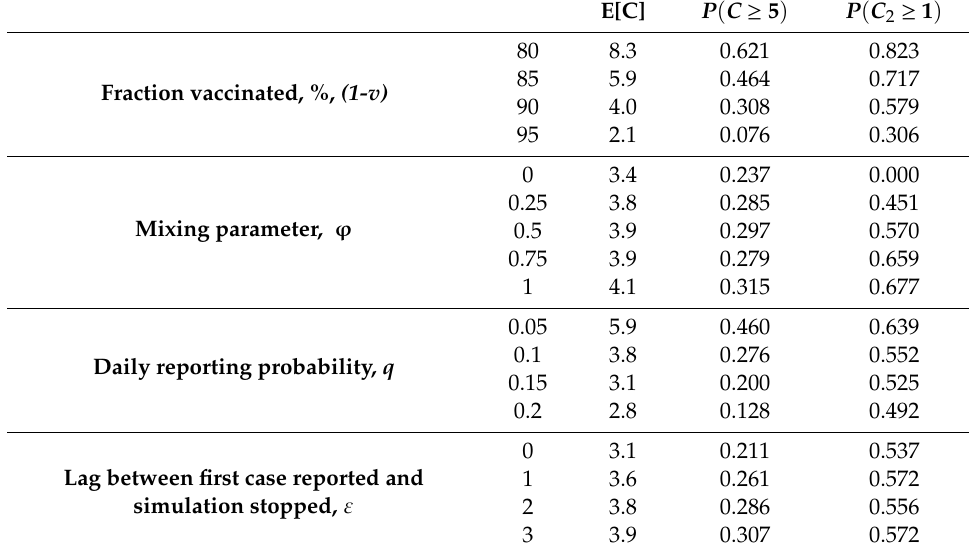
Table 4. Sensitivity analysis for two unequal-sized groups, an elementary school of 500 and a high school of 2000 individuals. The initial infection was in the elementary school and C 2 is the number of cases in the high school. There were 1000 replications. The standard error was less than 0.23 for E[ C ] and 0.02 for P[ C ≥ 5] and P[ C 2 ≥ 1]. E[C] P ( C ≥ 5 ) P ( C 2 ≥ 1 )